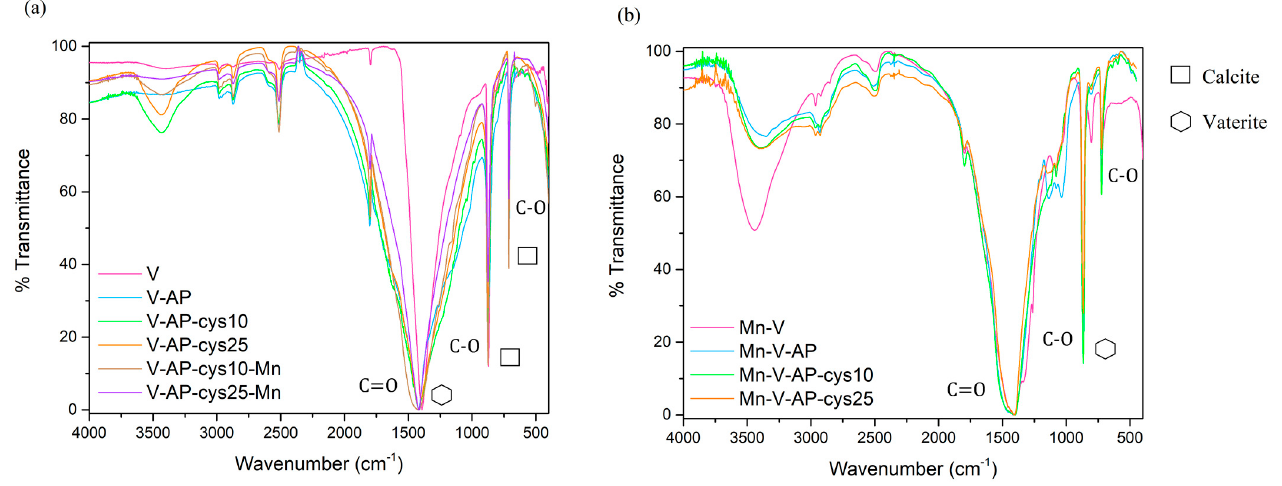
Figure 1. Comparative FT-IR spectra: ( a ) V Series, ( b ) Mn-V Series.